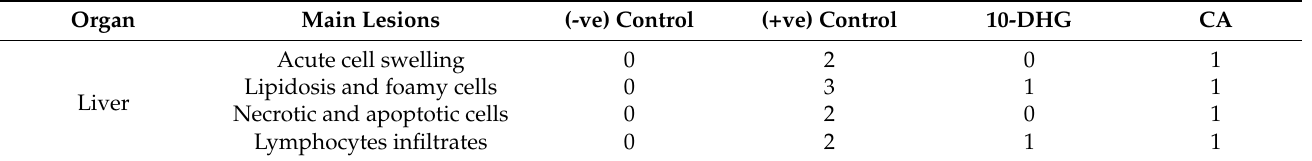
Table 3. Lesion scores of the severity extent in the hepatic tissues among different groups.